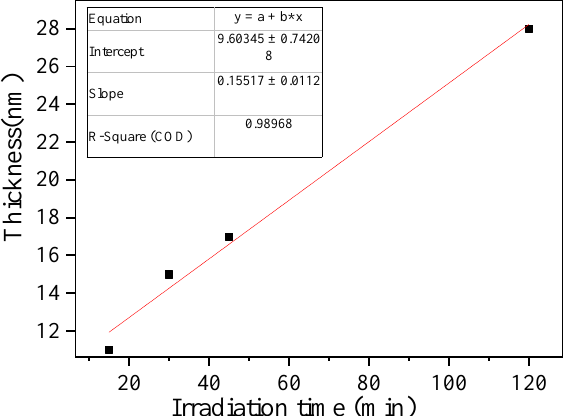
Figure 5. Influence of irradiation time on imprinted PVC@TAA-MIP film thickness.